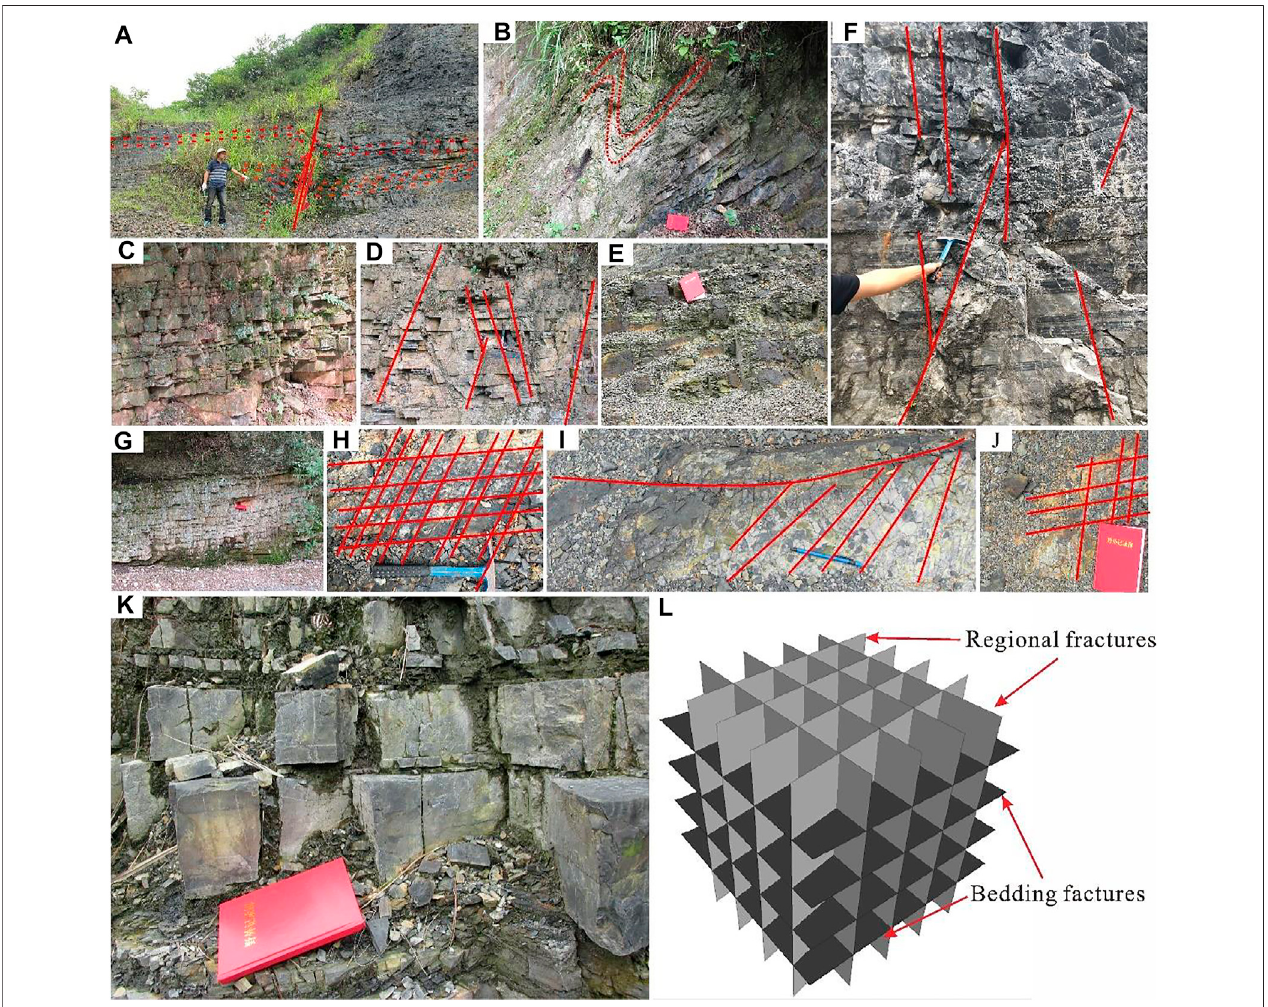
FIGURE 7 | Outcrop fracture characteristics in the Xiaobao geological section of Cen ’ gong block. (A) Fault-bend folds and related fractures; (B) slip fold between layers and related fractures; (C) bedding fractures; (D) high dip angle fractures cutting bedding factures; (E) regional fractures; (F) high dip angle fractures; (G) bedding fracturesdevelop differentlyindifferentlayers; (H) regionalfracturesinagrid pattern; (I) plumosefractures; (J) twogroupsoffracturescuttingoffeach other; (K) regional fractures and bedding fractures; (L) 3D schematic diagram showing the regional fractures and bedding fractures.